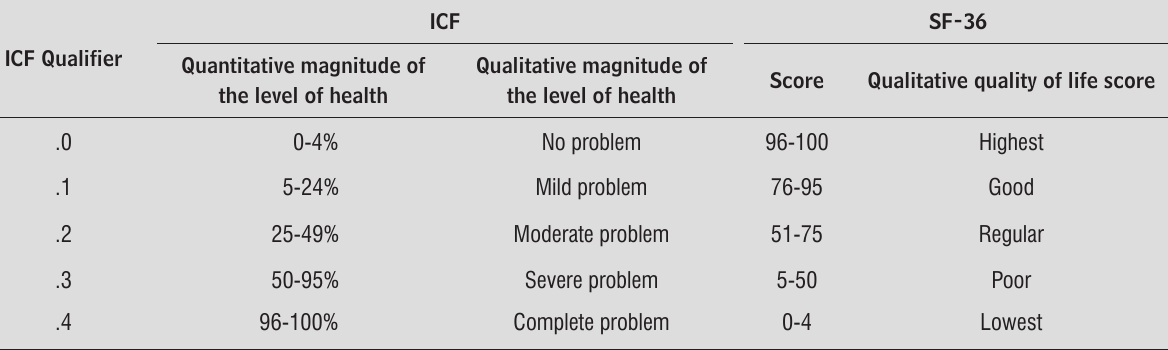
Table 3 - Relationship between quantitative and qualitative descriptors of the ICF and the scores of the SF-36